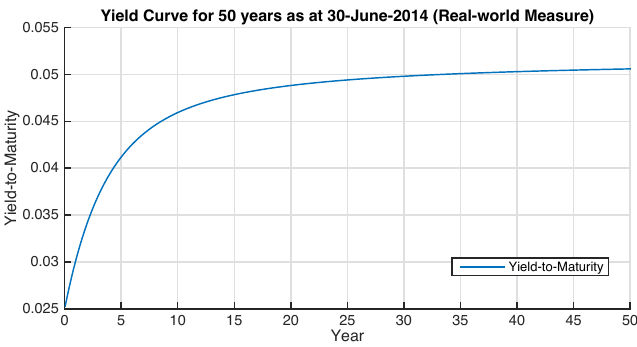
Figure 2. Yield Curve for 50 years as at 30 June